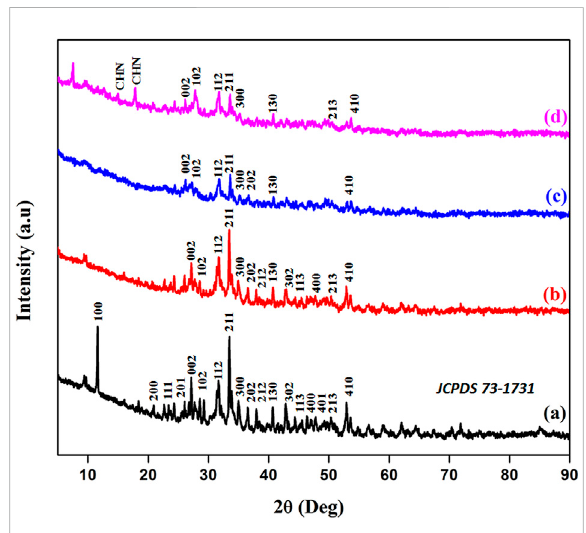
FIGURE 2 XRD patterns of (A) HAP ceramic, (B) HAP/COL composite, (C) HAP/COL/CCQD composite, and (D) HAP/COL/CCQD/CRN